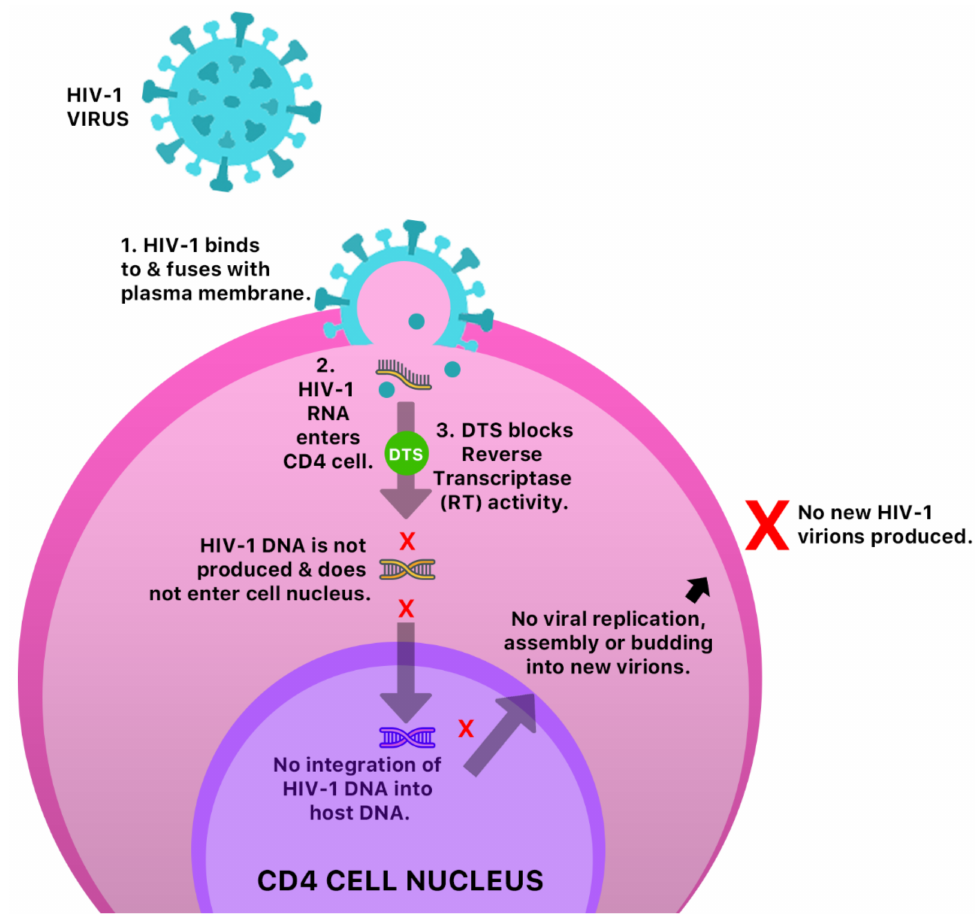
Figure 7. A possible anti-HIV-1 mechanism of DTS in a CD4